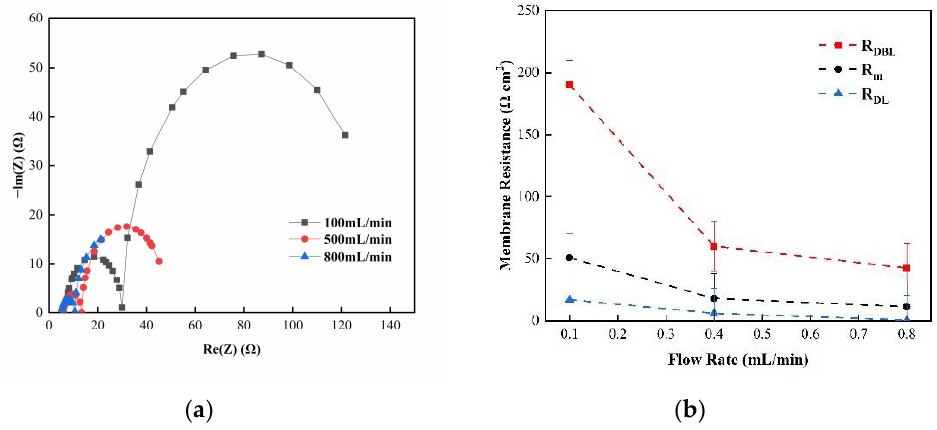
Figure 5. Relationship between the measured membrane electrical resistance and solution circula- tion velocity (0.5 M NaCl).